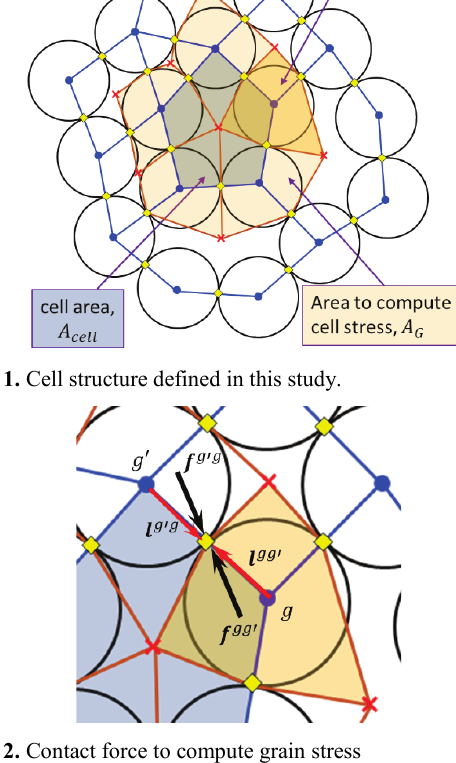
Fig. 2. Contact force to compute grain stress